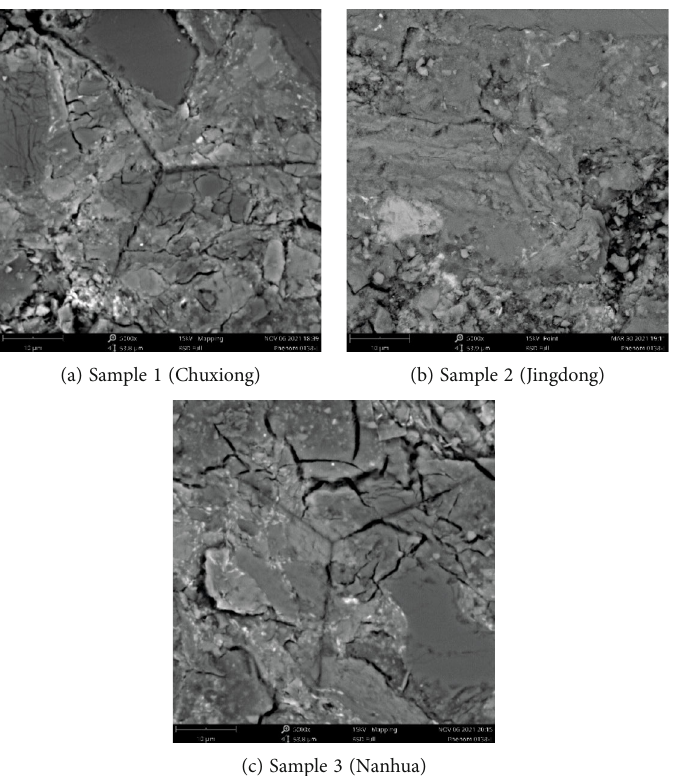
Figure 10: Comparative analysis of residual indentation morphology of Yunnan red-bed mudstone in the three regions.